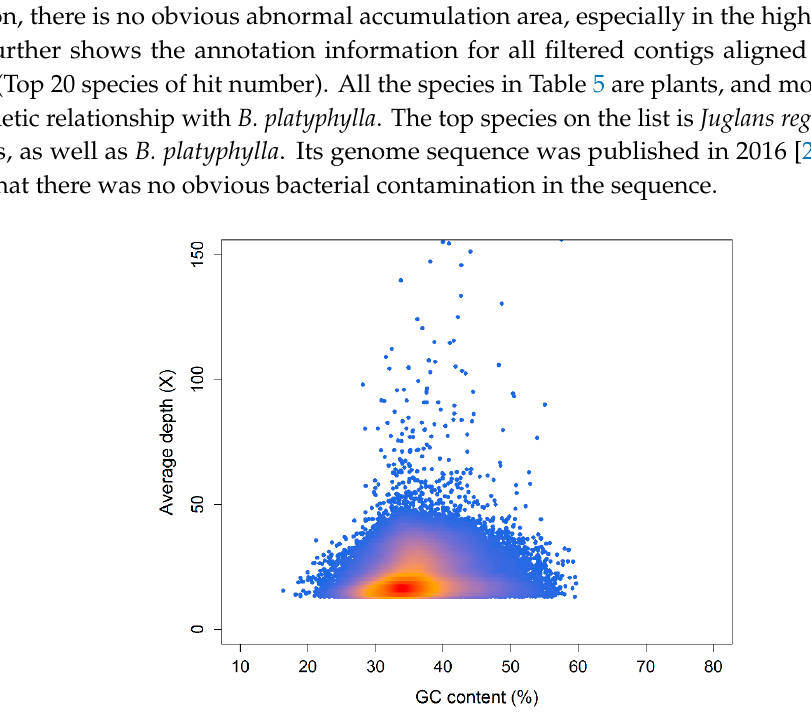
Figure 6. GC depth distribution of B. platyphylla tissue culture